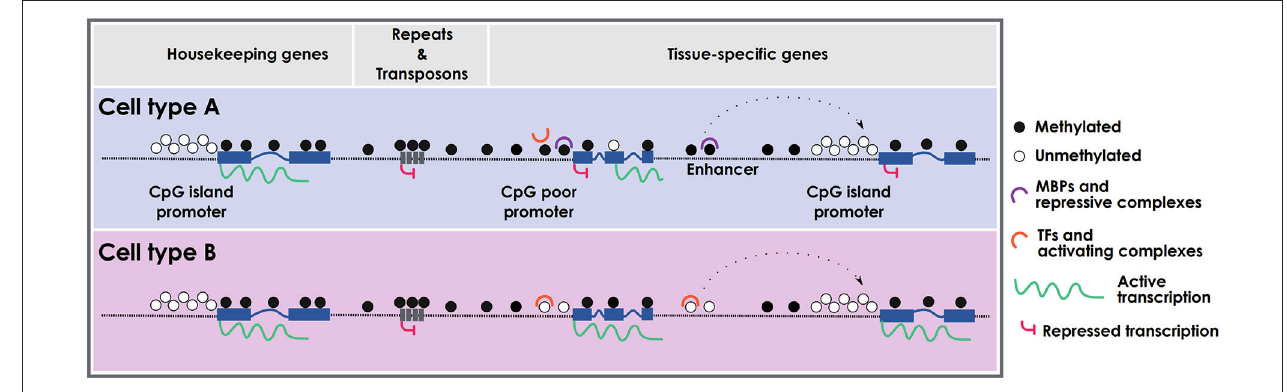
with the exception of enhancers and CpG-poor promoters that can be differentially methylated in a cell type-specific fashion. Intragenic regions can also be differentially methylated leading to specific cell-type transcripts. MBPs: methyl-binding proteins; TFs: transcription